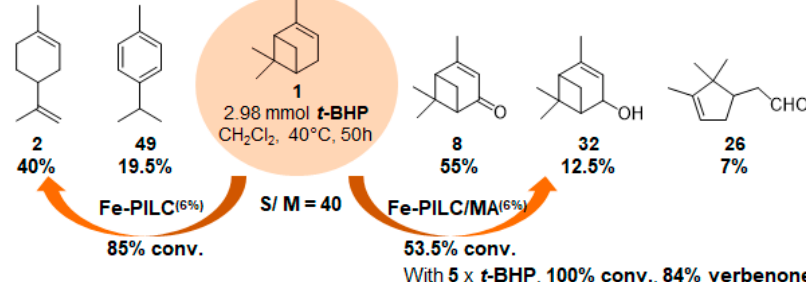
Figure 12. Influence of the type of Fe-pillared montmorillonite on α -pinene oxidation (Fe-PILC: Fe- pillared montmorillonite, Fe-PILC/MA: mechanochemically activated Fe-pillared montmorillonite) (adapted from reference [67]).